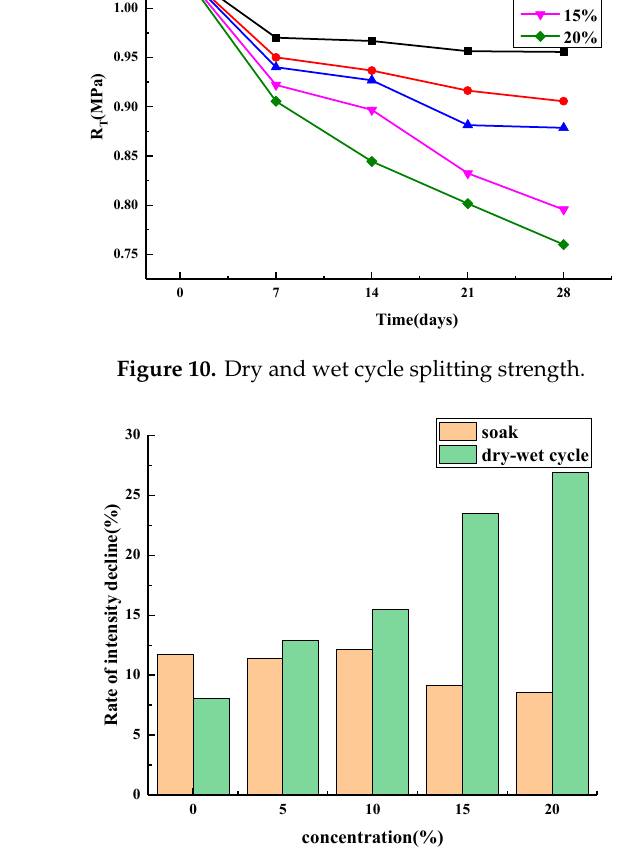
Figure 11. Damage degree of splitting strength at 28 days.